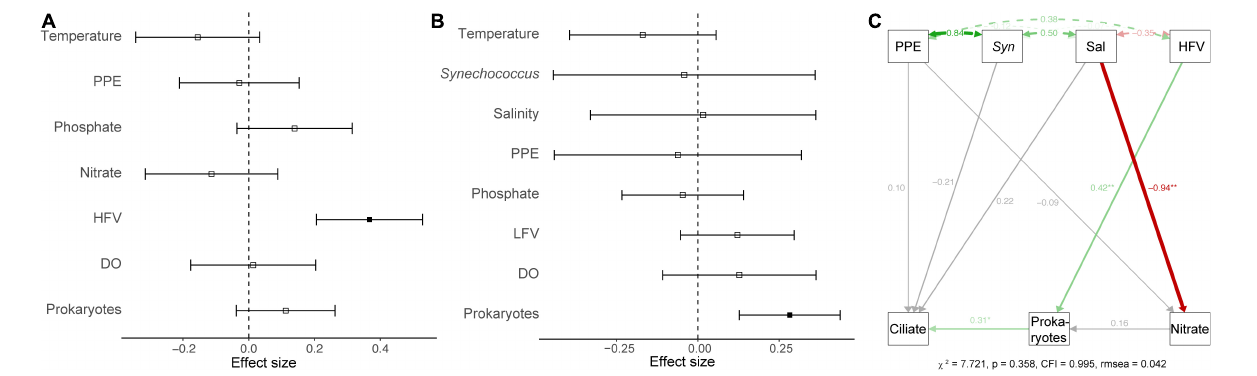
FIGURE 3 | A generalized linear model showed the effect of environmental variables on the abundance (A) and biomass (B) of ciliates. Significant ( p < 0.05) and non-significant ( p > 0.05) effects were marked by the solid or non-solid square dots, respectively. (C) Structural equation model that describes potential direct impacts of environmental variables (PPEs, Syn , salinity, HFV, heterotrophic prokaryotes, and nitrite) on ciliate biomass. The solid green and red arrows indicated significant ( p < 0.05) positive and negative associations, respectively. The gray arrows indicated that the correlations were non-significant ( p > 0.05). Double-headed arrows represented covariances. Path coefficients are displayed next to arrows and represent the expected change in the response given a one-unit change in the predictor given the other variables.